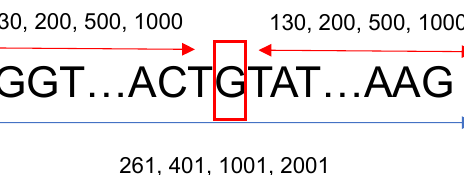
Figure 1. Input genomic sequences for the models. Different flanking lengths of neighboring nucleotides located left and right from each nucleotide of interest were tested: 130, 200, 500, 1000; therefore, the lengths of the sequences that were introduced into the deep learning models were 261, 401, 1001, and 2001 nucleotides